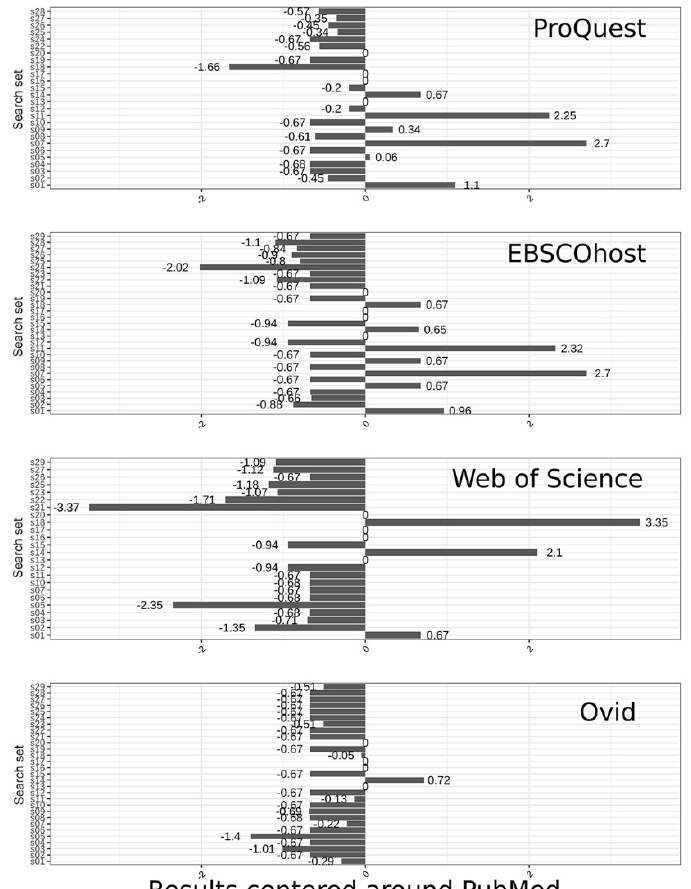
Figure 2 Deviations per platform from PubMed’s MEDLINE, excluding outlier